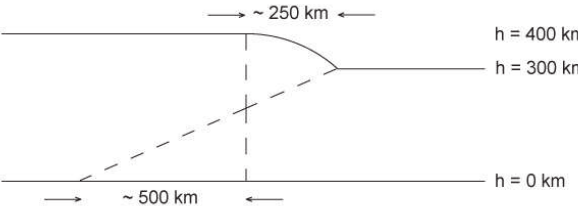
Fig. 8. Geometric optics argument for focussing of reflected signals near the dawn terminator. Supposing the dayside F-region forms first at higher altitudes (where sunrise occurs earlier) and later at lower altitudes, a beveled or curved reflecting surface might form as shown, concentrating rays on the western side of the termina- tor. Assuming a circular curved surface between 300 and 400km extending 250km horizontally implies 3dB enhancement of power over a 500km extent west of the terminator (20min in local time preceding